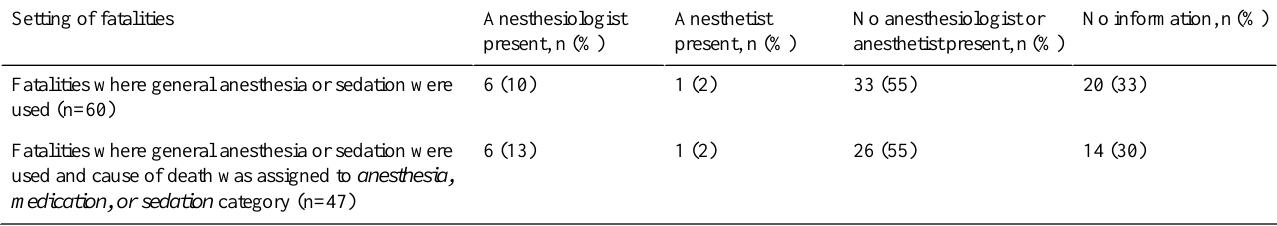
Table 3. Fatalities in dental practices under general anesthesia and sedation with respect to the presence of an anesthesiologist or anesthetist, based on data from online publications in the United